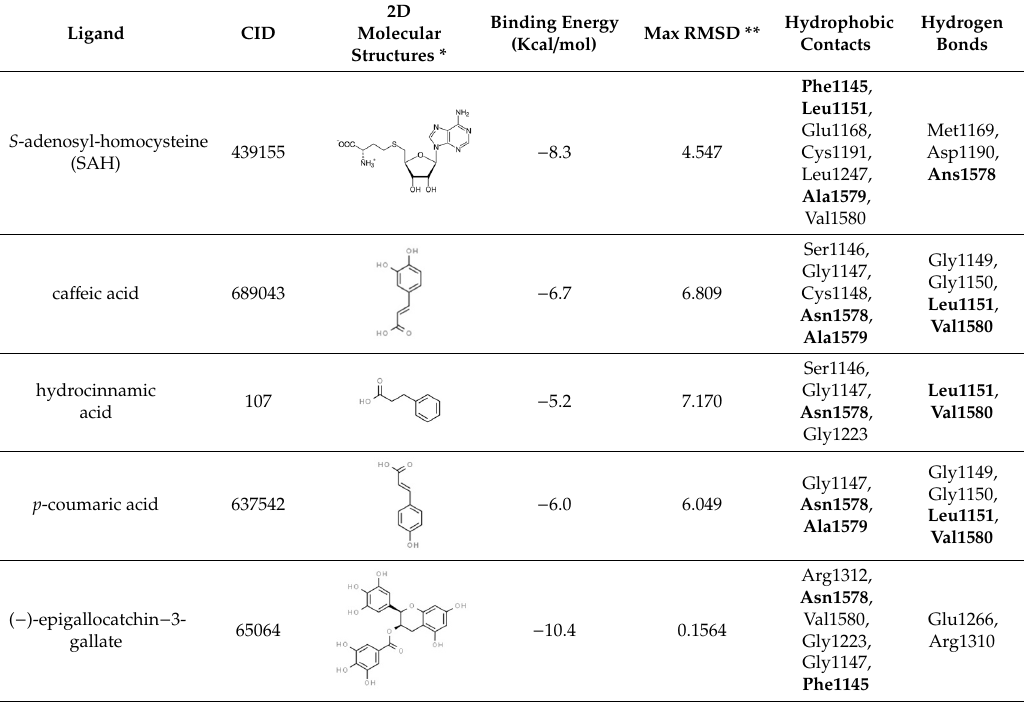
Table 1. Computational predictions of interactions between ligands and MTase domain of human DNMT1 by molecular docking. Concordant amino acid residues involved in the predicted interactions Table 1 . Computational predictions of interactions between ligands and MTase domain of human Table 1 . Computational predictions of interactions between ligands and MTase domain of human are indicated in bold. Table 1 . Computational predictions of interactions between ligands and MTase domain of human DNMT1 by molecular docking. Concordant amino acid residues involved in the predicted Table 1 . Computational predictions of interactions between ligands and MTase domain of human DNMT1 by molecular docking. Concordant amino acid residues involved in the predicted Table 1 . Computational predictions of interactions between ligands and MTase domain of human DNMT1 by molecular docking. Concordant amino acid residues involved in the predicted interactions are indicated in bold. DNMT1 by molecular docking. Concordant amino acid residues involved in the predicted interactions are indicated in DNMT1 by molecular docking. Concordant amino acid residues involved in the predicted interactions are indicated in bold. interactions are indicated in bold. interactions are indicated in bold.